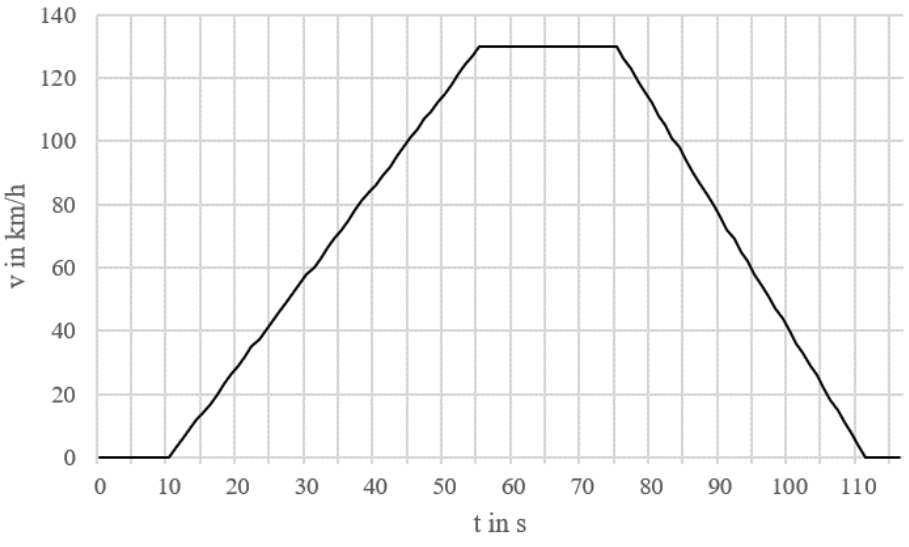
Figure 1. Example velocity profile with maximum speed 130 km/h.